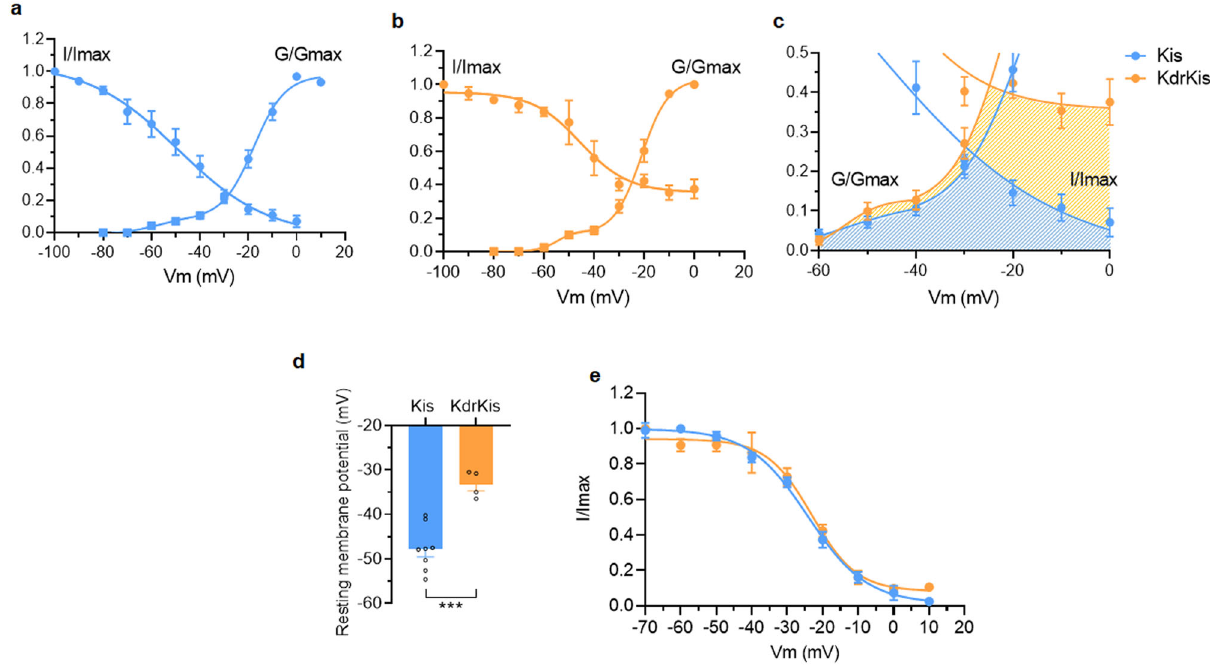
Fig. 7 Biophysical properties of the voltage-gated sodium currents in neurons isolated from Kis and KdrKis strains in fl uence membrane potential and voltage-gated calcium channel availability. a , b Voltage-dependence of steady-state inactivation and conductance parameters of the voltage-gated inward sodium current in Kis ( a , n = 7 – 8) and KdrKis ( b , n = 4 – 6) neurons. Data points are mean values ± S.E.M. Smooth curves were fi tted through the data points using Boltzmann distributions (see Eqs. 8 and 9 for normalized conductance and inactivation, respectively). c Enlarged colored areas indicate overlap between activation and inactivation curves for Kis (blue) and KdrKis (orange) neurons, which is expected to result in a window current; this window current being largest for KdrKis voltage-gated sodium channels. d Comparative histogram illustrating the values of the resting membrane potential recorded under current-clamp condition in Kis and KdrKis neurons. Bars represent mean ± S.E.M. ( n = 8 and n = 4 for Kis and KdrKis neurons, respectively). The statistical test used was Student unpaired t -test, ** p < 0.01. e Voltage-dependent steady-state inactivation of the voltage-gated calcium current studied with the two- pulse voltage-clamp protocol (see text for details) in Kis ( n = 7) and KdrKis ( n = 4) neurons. Smooth curves of inactivation were fi tted through data points using Boltzmann distribution (Eq. 9). Data are mean ± S.E.M. In all cases, the number of experiments ( n ) are biologically independent